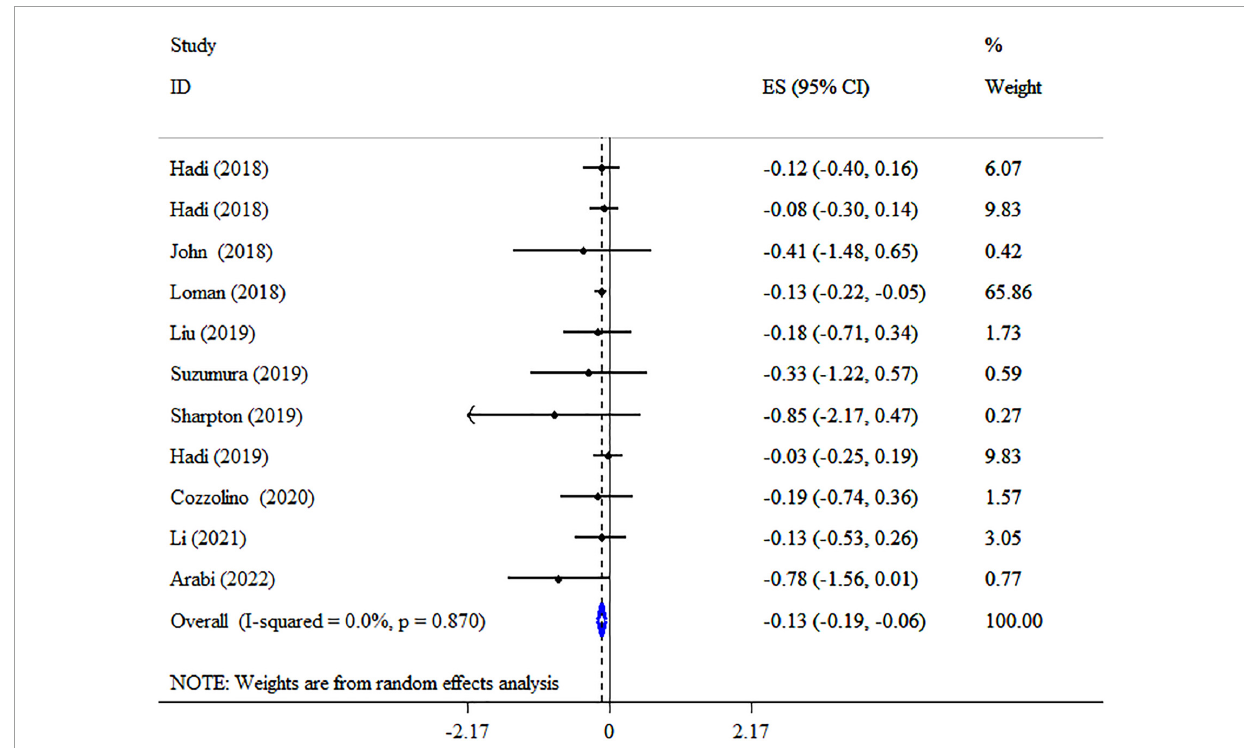
FIGURE2 Forest plot with a mean difference and 95% confidence intervals (CIs) the impacts of synbiotic supplementation on BMI